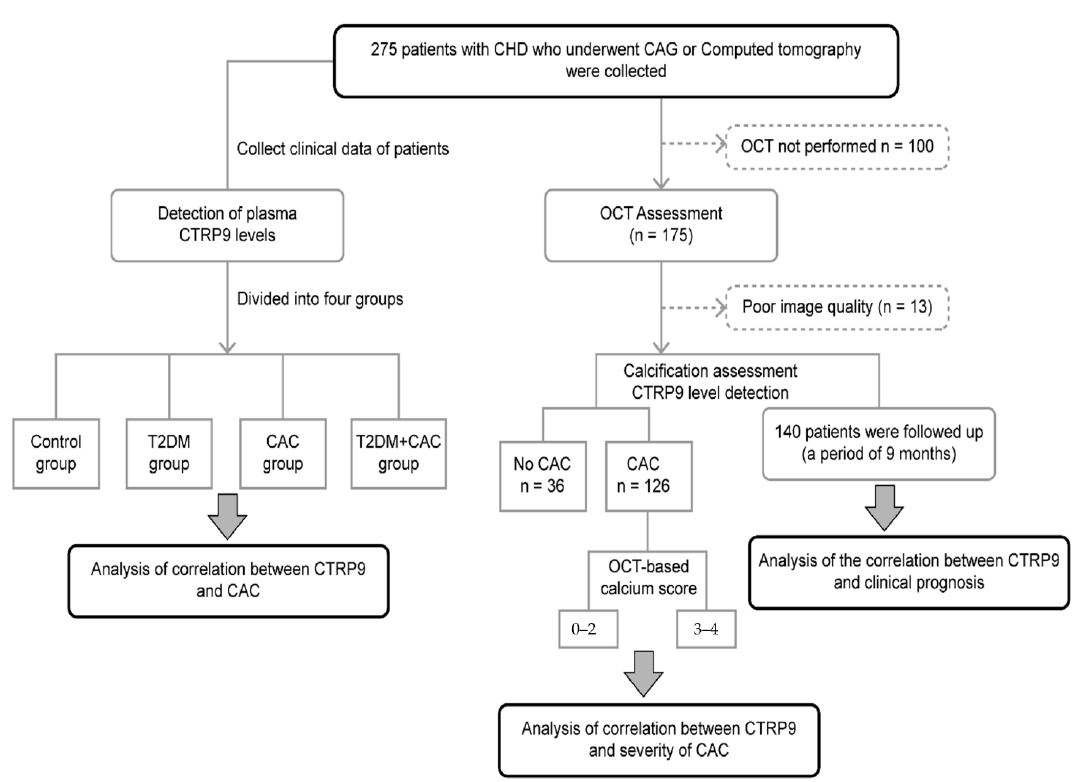
Figure 1. Flow chart to study the relationship between CTRP9 and coronary artery calcification.